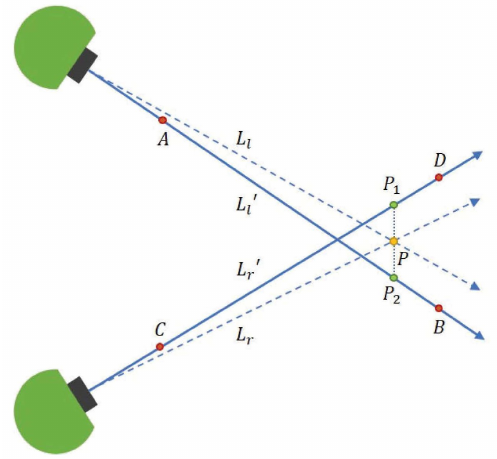
Figure 4. The actual model of our proposed